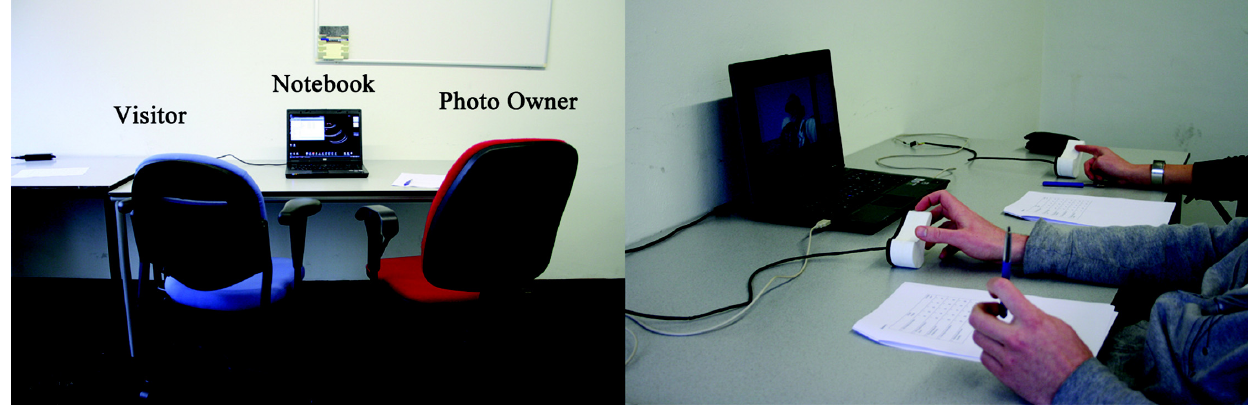
Figure 4. The dyad experiment